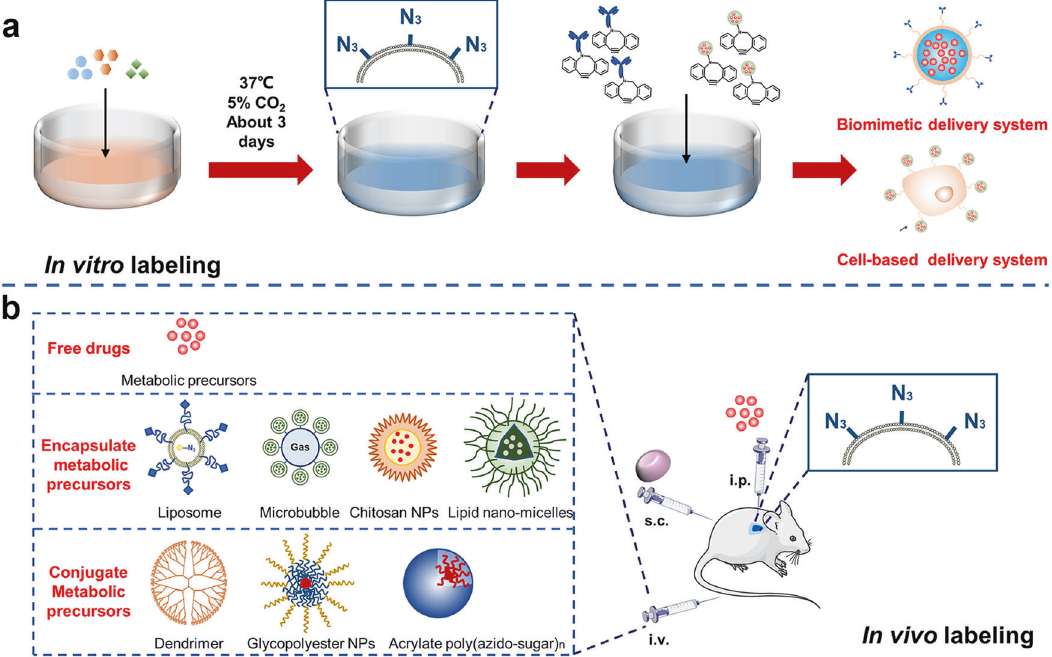
Fig. 2 In vitro and in vivo strategies of bioorthogonal metabolic labeling. a In vitro bioorthogonal metabolic labeling strategies. Co-incubation of metabolic precursors with cells enables in vitro labeling. b In vivo bioorthogonal metabolic labeling strategies. Subcutaneous injection of unnatural sugar-encapsulated gels, intratumoral or intravenous injection of metabolic precursors, and the use of nanocarriers through physical encapsulating or chemical conjugating of metabolic precursors enable bioorthogonal metabolic labeling in